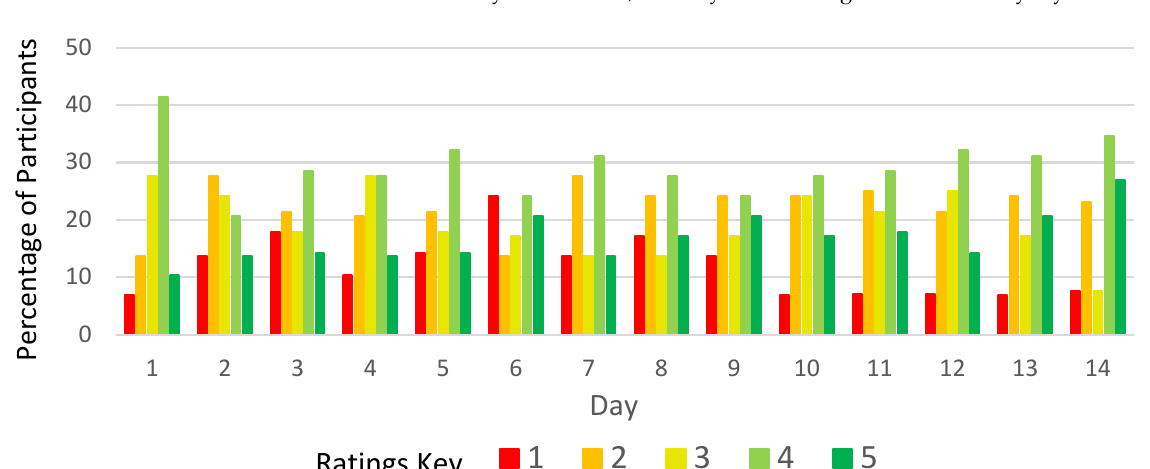
Scheme 2. Results show the percentage of child participants’ (aged 5–12) responses to the question: